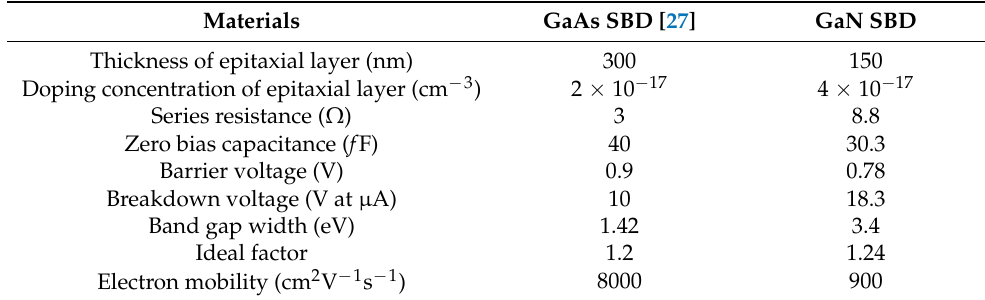
Table 1. Comparison of main parameters of the GaAs and GaN SBD with one anode. Materials GaAs SBD [27] GaN SBD Thickness of epitaxial layer (nm)